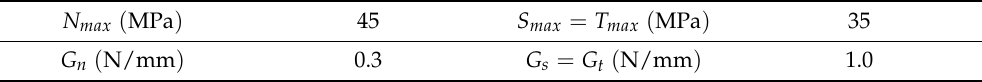
3 × 10 5 N/mm 3 . Table 4. Interface properties of five-harness satin weave SiC f /PyC/SiC composite [37]. N max ( MPa